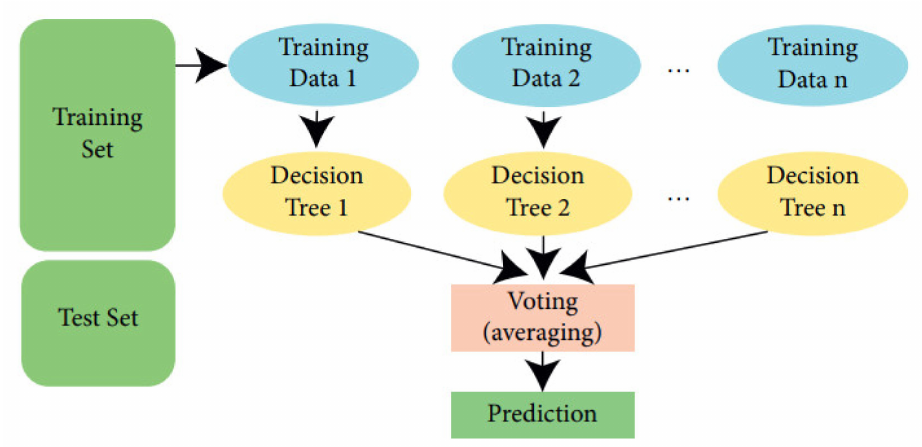
Figure 2. The random forest algorithm